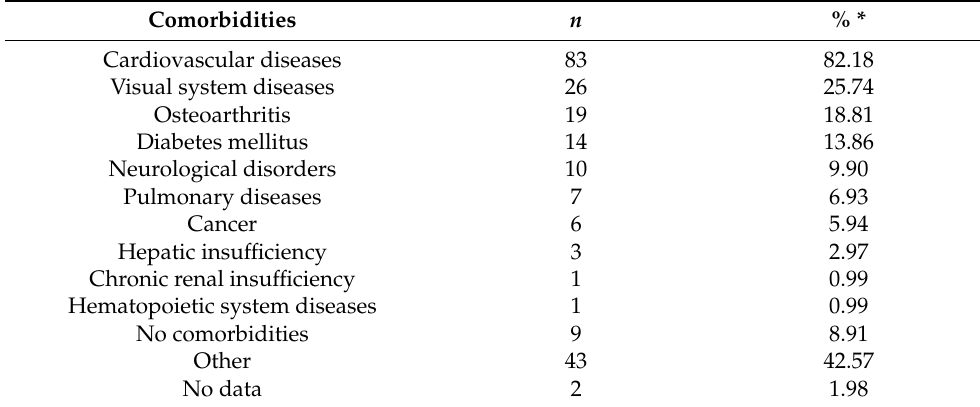
Table 2. Comorbidities in patients.